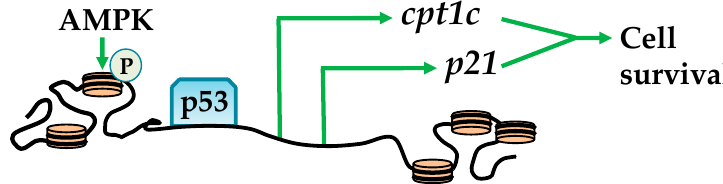
Figure 1. AMPK (AMP-activated protein kinase) promotes cell survival through histone phosphorylation. AMPK phosphorylates H2B to promote chromatin relaxation at tumor protein p53 (p53) recognized promoters and transcription of carnitine palmitoyltransferase 1C ( cpt1c ) and cyclin- dependent kinase inhibitor (p21 ) to enhance cell